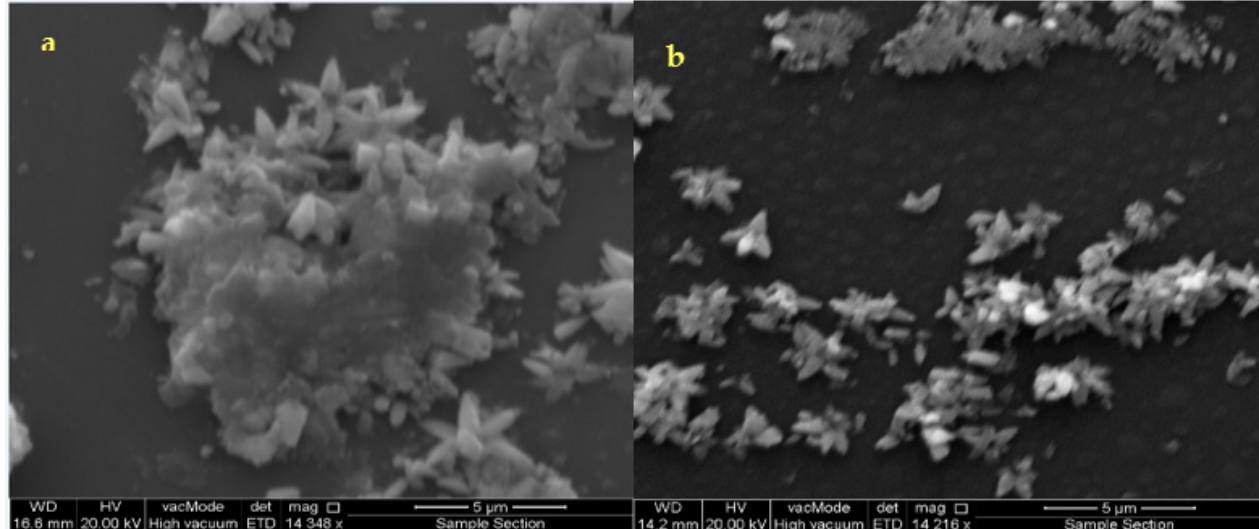
Figure 3. SEM microphotographs of the as-deposited ZnS thin film ( a , b ) annealed at 300 °C.